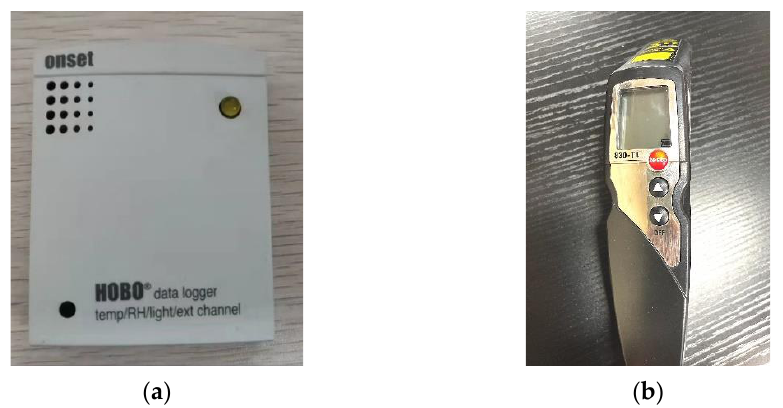
Figure 4. Experimental instruments: ( a ) HOBO U12-012 ; ( b ) Testo 830-T4 .